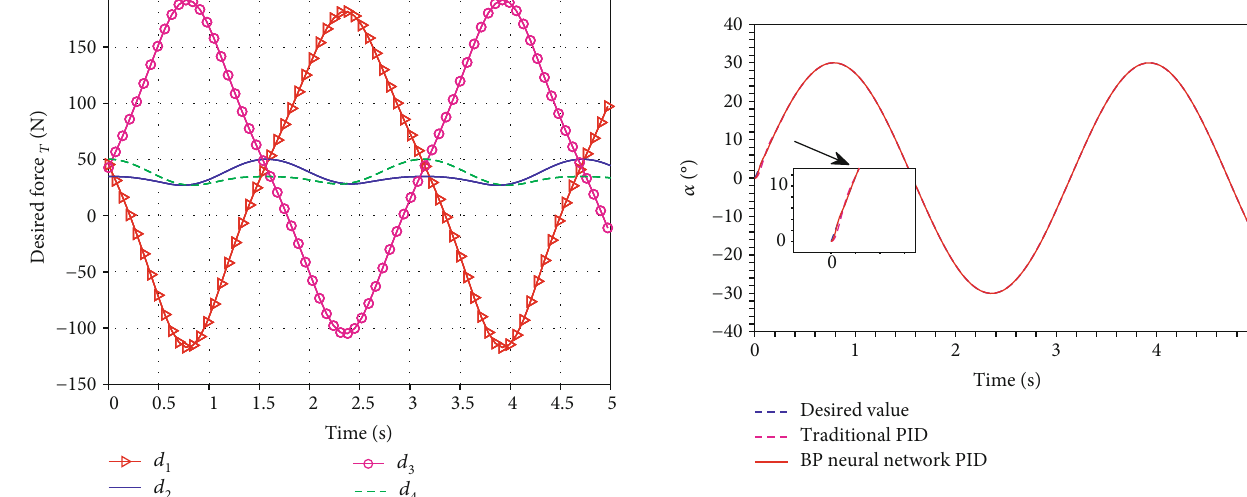
Figure 16: The trajectory tracking comparison about Euler angle α